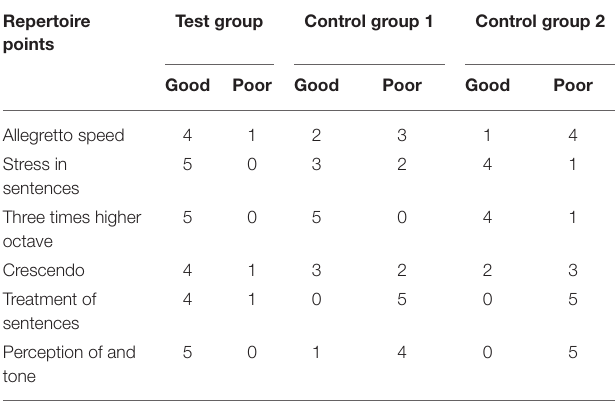
FIGURE 3 | Comparison of piano learning attitudes between groups before and after the experiment in grade 6 (C refers to the C experimental group, C1 refers to the C1 control group, C2 refers to the C2 control group. − 1, − 2, − 3, − 4, and − 5 refer to the numbers of the five students, respectively).